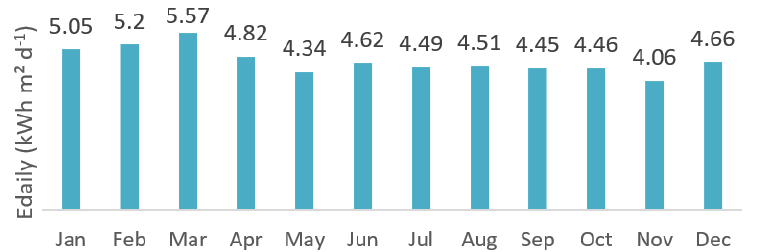
Figure 13. The daily solar irradiation on the module in kWh m − 2 d − 1 , obtained from [69]. The primary energy generated (A7) is the generated energy (A6) considering the energy carrier for renewable energy.